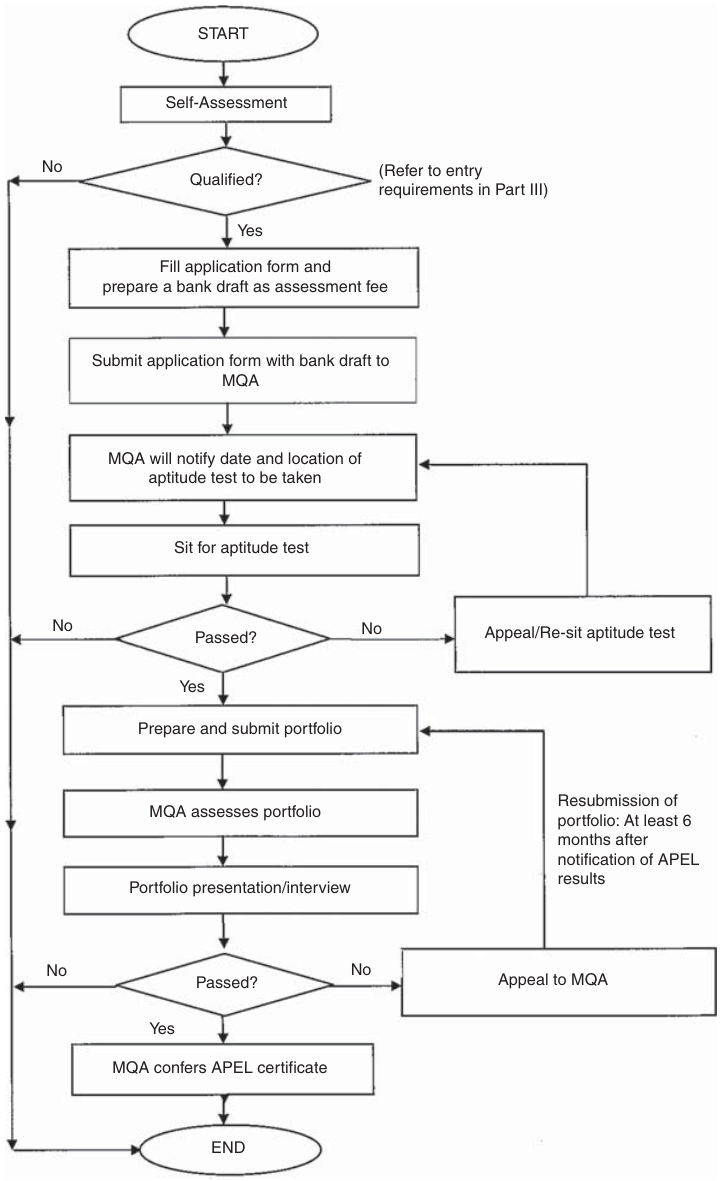
Figure 1. Flow chart of APEL certification process for masters